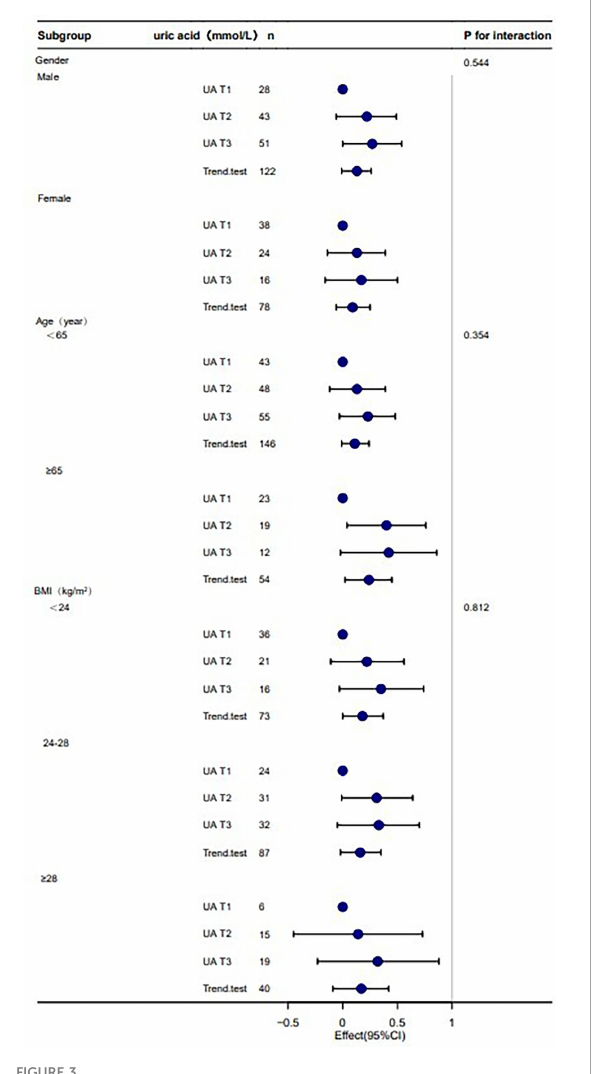
FIGURE 3 Strati fi cation analysis on the association between UA and phase angle. Note: adjust for age + duration + BMI + Lpa + WHR. UA, uric acid; T, tertile; n number; BMI, body mass